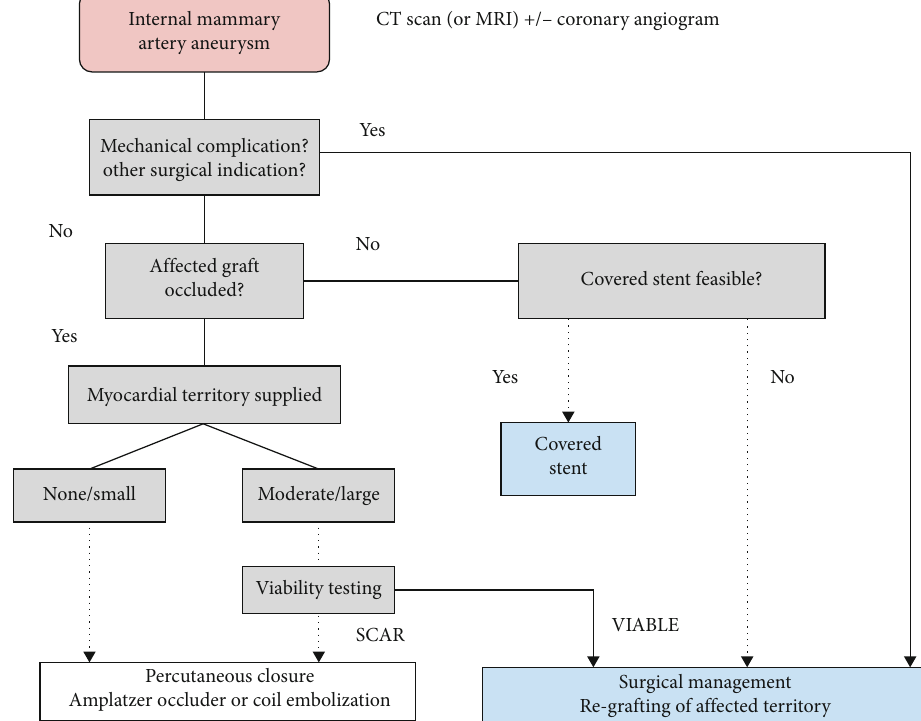
Figure 6: Suggested algorithm for assessment and treatment of an internal mammary artery aneurysm. CT: computed tomography; MRI: magnetic resonance imaging